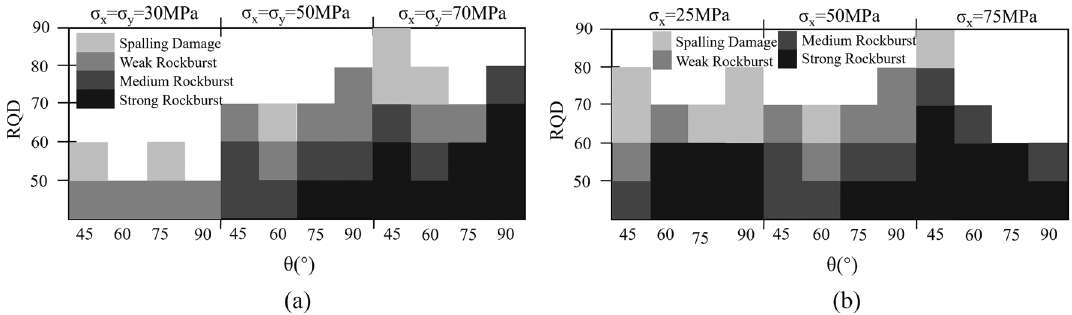
Fig. 31 Classification